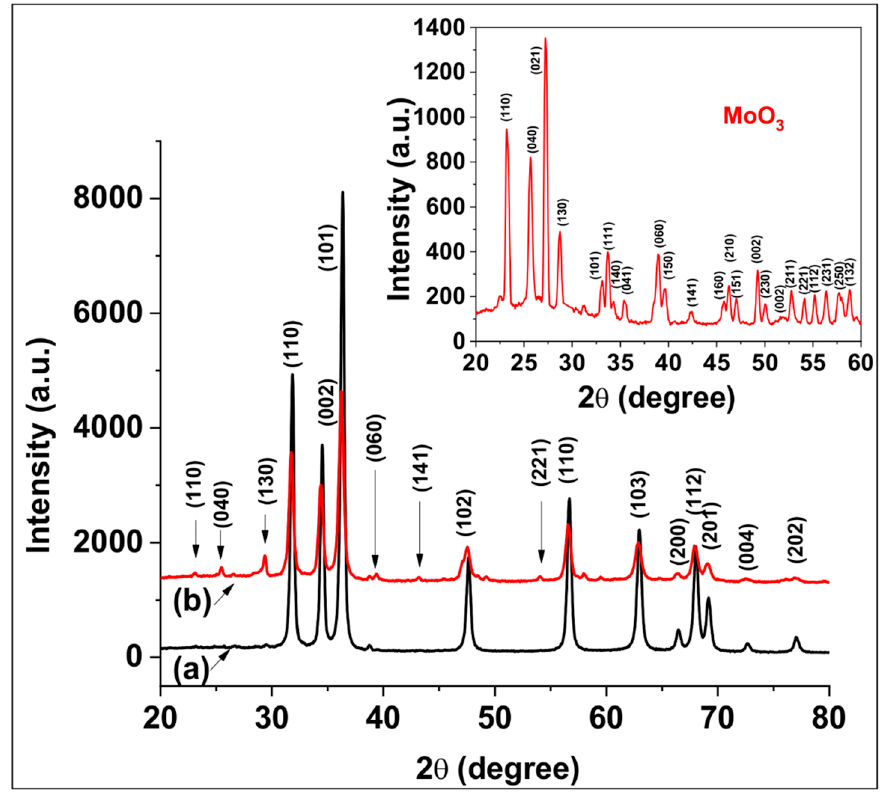
Figure 4. X-ray diffraction (XRD) patterns for pure ZnO ( a ), MoO 3 ( inset ) and ZnO:MoO 3 (S5) ( b ) composite material.